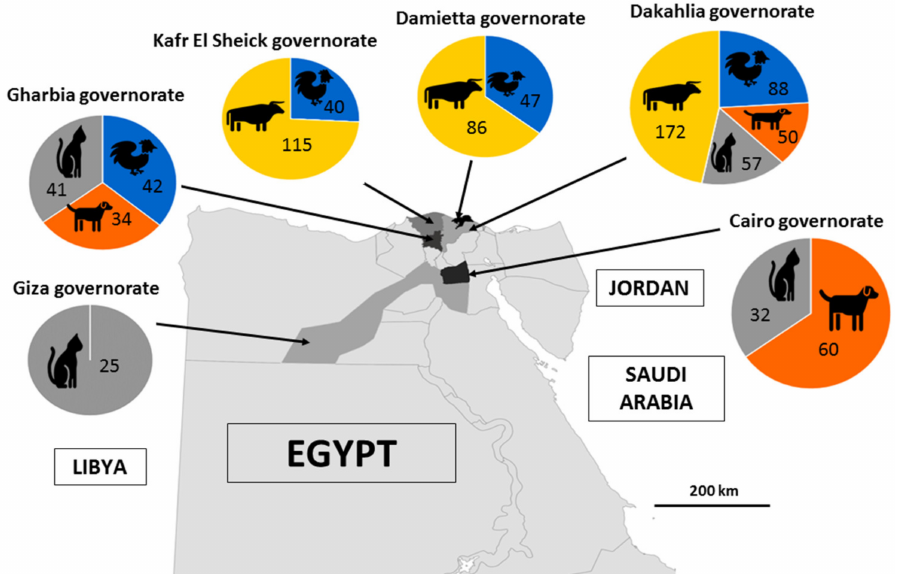
Figure 1. Study areas in Northern Egypt with the indication of the number of animals sampled for the selected species in each